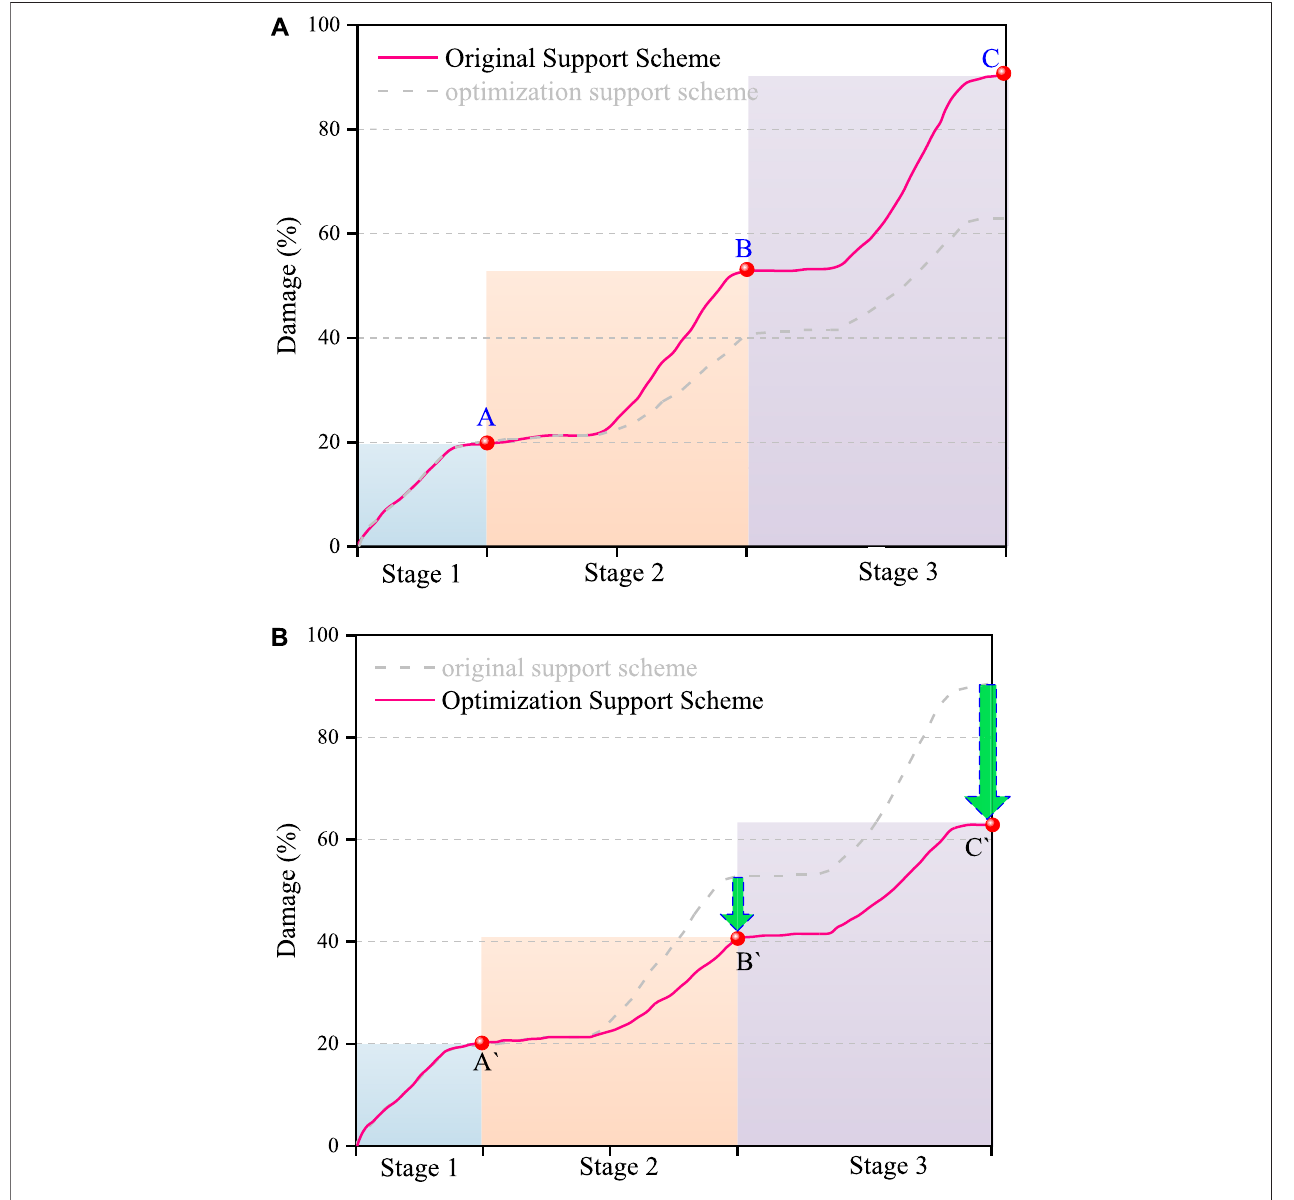
FIGURE 10 | The damage change law of coal pillar at different stages. (A) original support scheme; (B) reinforced support scheme.